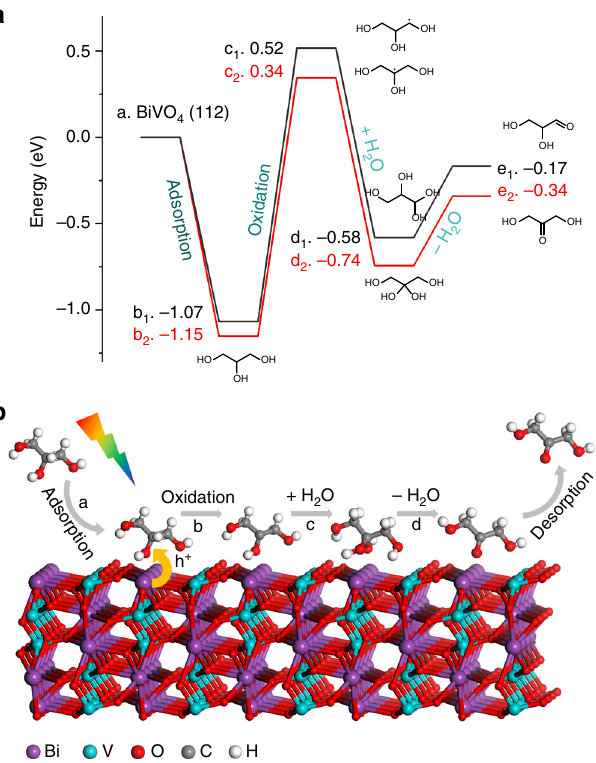
Fig. 5 Reaction mechanism. a Energy pro fi le of glycerol oxidation on BiVO 4 . 1 (black) and 2 (red) stand for reactions that take place at the terminal and middle carbon, respectively. b Schematic illustration showing PEC glycerol oxidation to